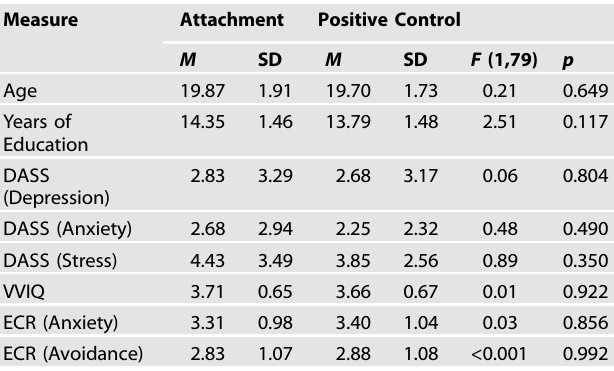
Table 1. Participant characteristics broken down into means and standard deviations for each